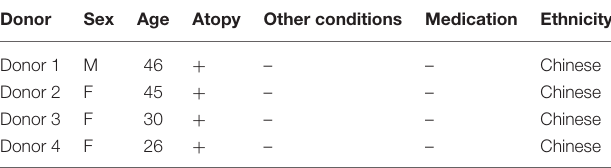
TABLE 1B | PBMC donor